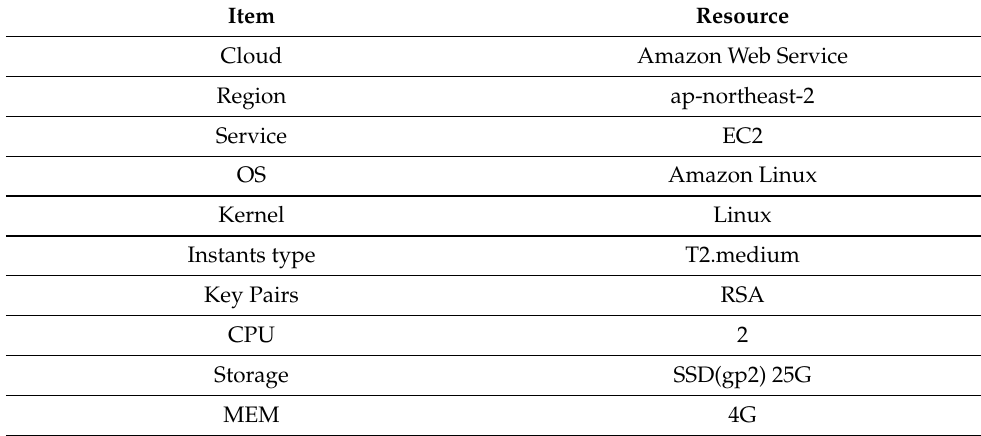
Table 2. Cloud server computing